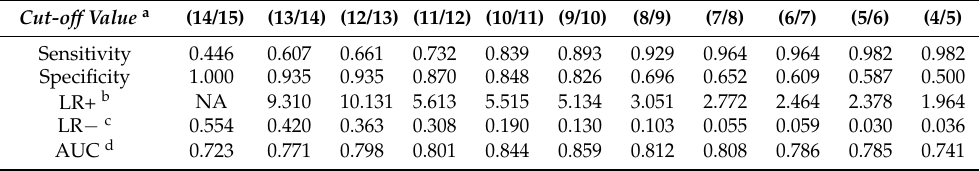
Table 2. The results of diagnostic accuracy indices and the corresponding cut-off values of IGDS-SF-T.